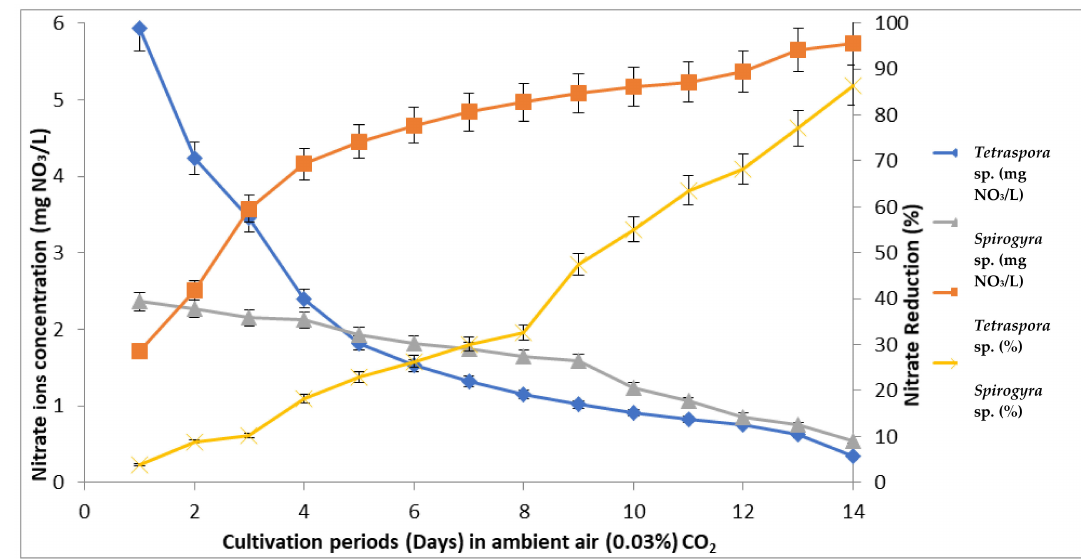
Figure 2. Nitrate ions (NO 3 − ) concentration profile during the 14 day cultivation periods for Tetraspora sp. and Spirogyra sp. aerated with ambient air (0.03% of CO 2